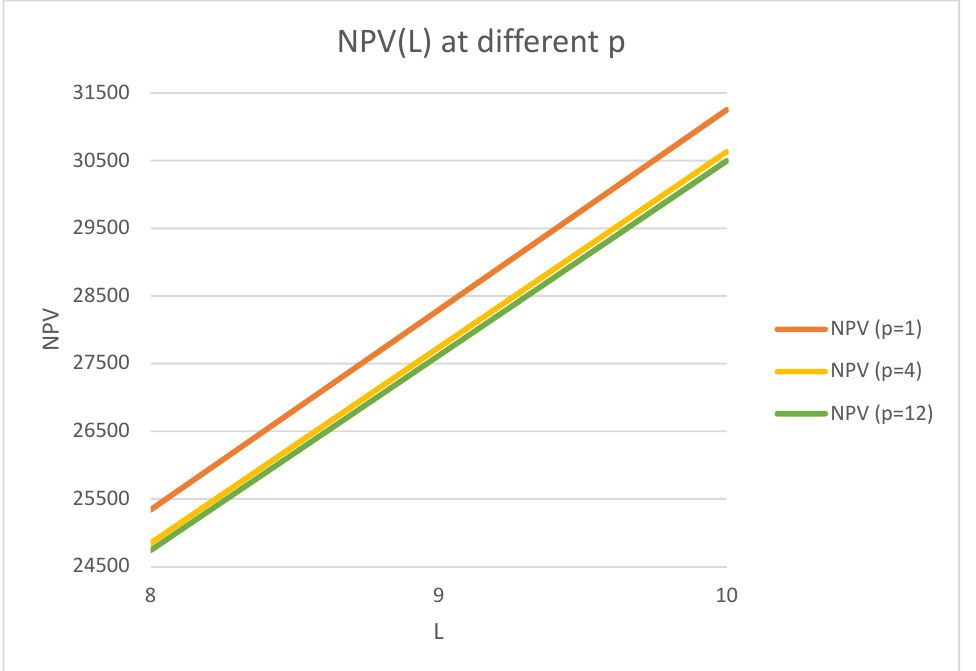
Figure 9. Change of net present value, NPV, with leverage, L , for k d = 0.14, k 0 = 0.22, and p = 1, 4, and 12, for a perpetuity project (larger scale).